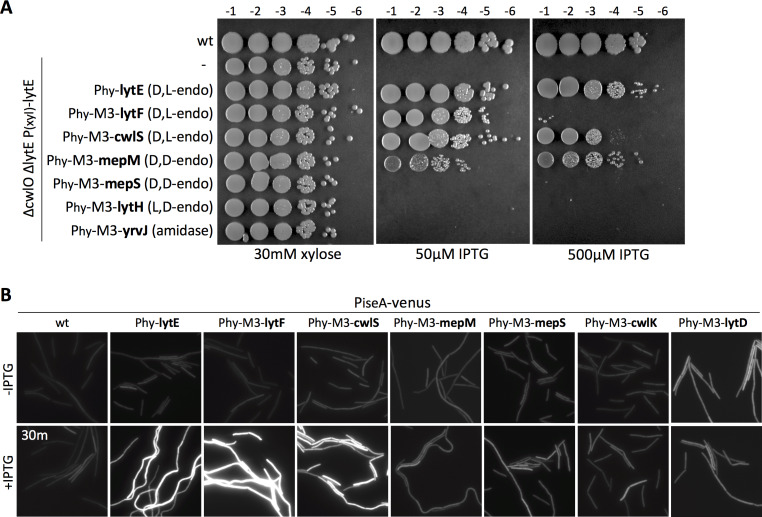
D,L-endopeptidase chimeras and the MepM D,D-endopeptidase chimera complement a ΔlytE ∆cwlO double mutant but only D,L-endopeptidase activity lowers WalRK activity.(A) Spot dilutions of strains lacking cwlO and lytE (∆cwlO ∆lytE), a xylose-regulated allele of lytE (P(xyl)-lytE) and the indicated chimera under IPTG control (Phy). Cells were grown in the presence of 30 mM xylose to OD600 ~2.0. The cultures were washed twice without inducer, normalized to an OD600 = 1.5, 10-fold serially diluted, and spotted (5 µL) onto LB agar plates with 30 mM xylose, 50 µM IPTG, or 500 µM IPTG. Representative plates from one of two biological replicates are shown. (B) Representative fluorescence images of strains harboring PiseA-venus and the indicated chimera under IPTG control (Phy). Cells were imaged before or 30 min after addition of IPTG. 50 µM IPTG was used to induce LytE and the D,L-endopeptidase chimera and 500 µM IPTG was used for all the other chimeras.